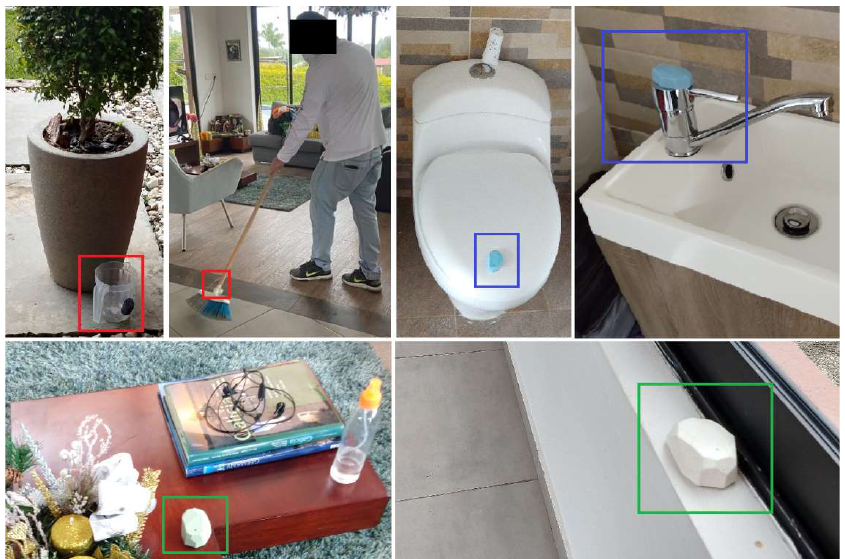
Figure 3. Beacons deployed. The two mobile beacons are in red squares (in jug and broom). Two of the six active beacons are in blue squares (toilet and bathroom sink). Two of five stationary beacons in green squares (living room and corridor).